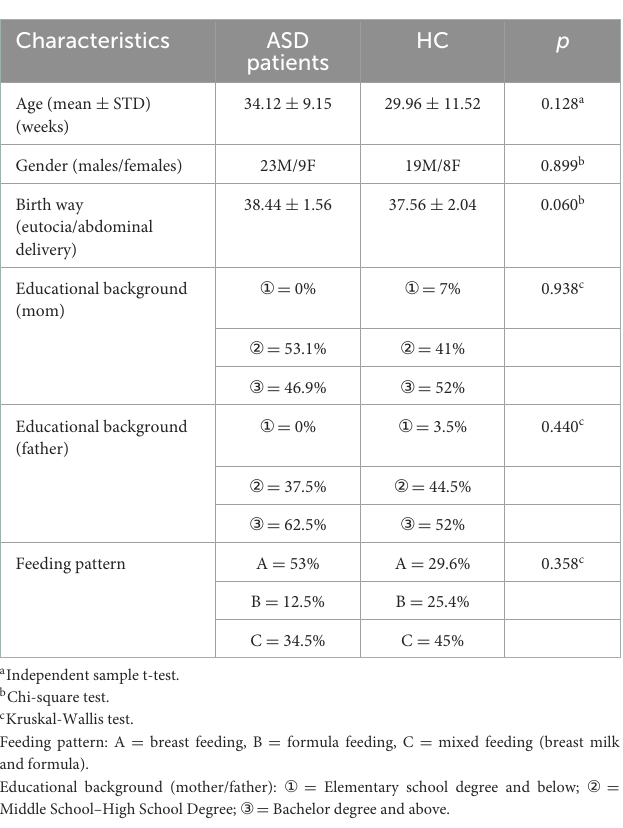
TABLE 1 Two groups demographic characteristics. TABLE 2 Between-group differences in Kurtosis fractional